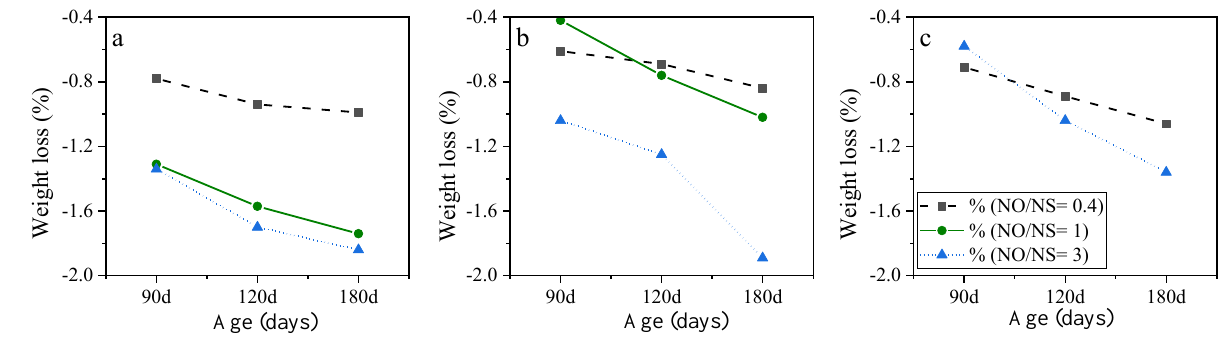
Figure 9. The effects of NO/NS ratios on weight loss at a molarity of ( a ) 6, ( b ) 10, and ( c ) 14.